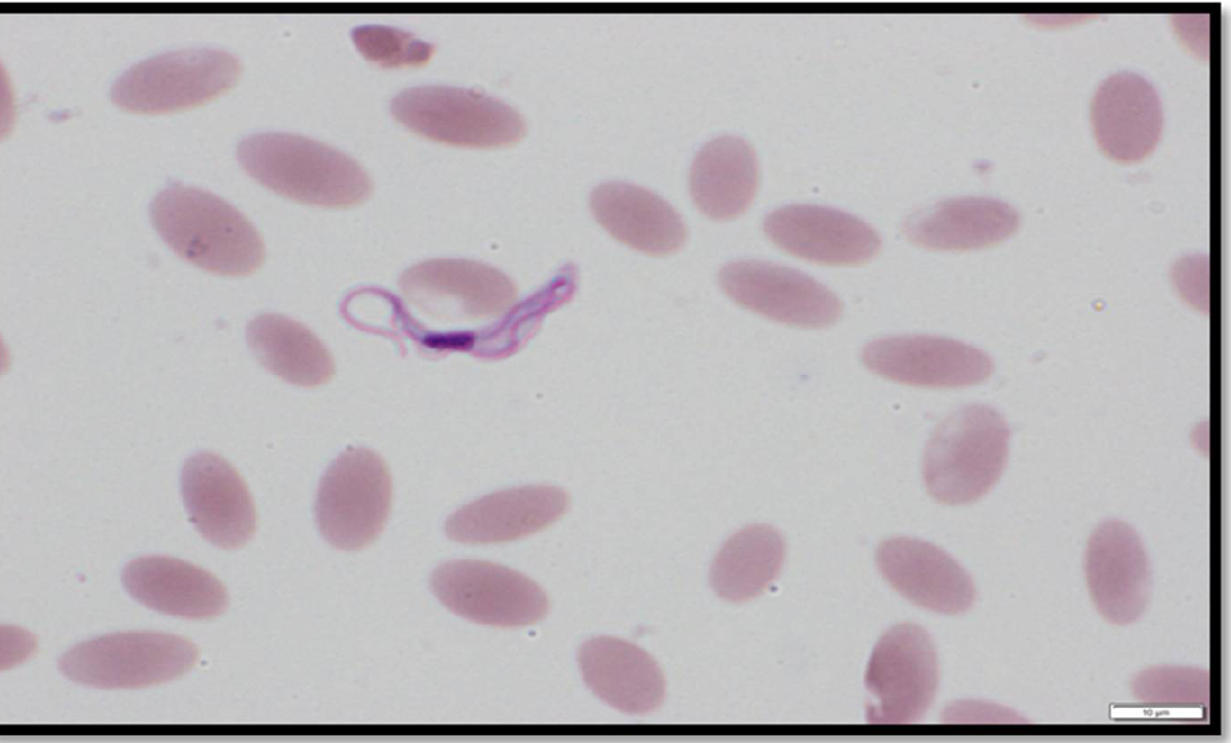
Figure 1. Trypanosoma evansi under a microscope (Olympus BX53, Tokyo, Japan).